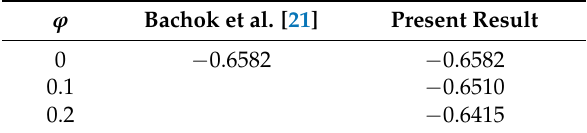
Table 3. Variation of λ c with σ = 0.2 and water-SWCNT for different value of ϕ .